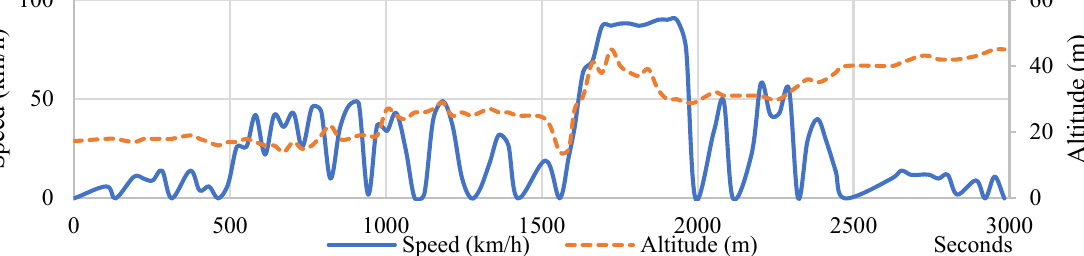
Figure 2. Drive cycle 1: GCM of 43,000 kg.